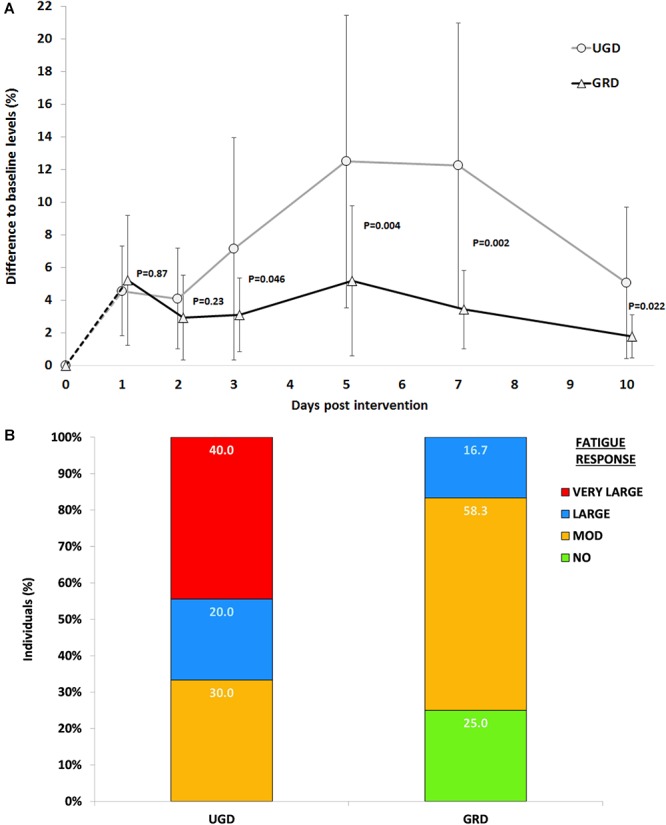
(A) Time course of the % increases with respect to baseline levels for CK-blood levels across the 10 days post intervention period. UGD, sham-grounded sleeping group; GRD, grounded sleeping group (mean ± SD). (B) Individual response analysis for increases in CK levels with respect to GRD (grounded sleeping) and UGD (sham-grounded sleeping). Percent differences are categorized as non-response: <3%, moderate response: 3–10%, large response: 10–20%, and very large response >20%.